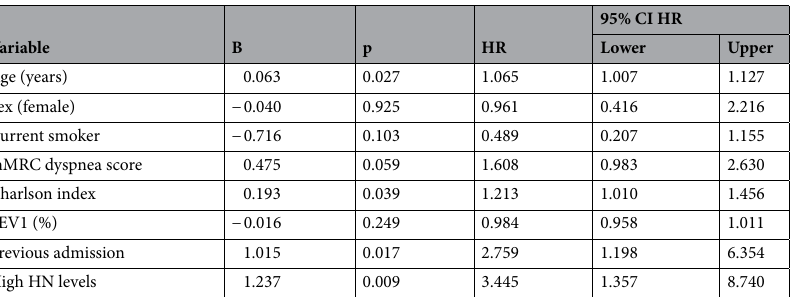
Table 6. Multivariate Cox proportional risk analysis showing predictors of COPD hospitalizations (dependent variable). High humanin levels = humanin higher than the median (> 246 pg/mL). Previous admission = 1 or more admission during previous year. FEV1 = forced expiratory volume in the first